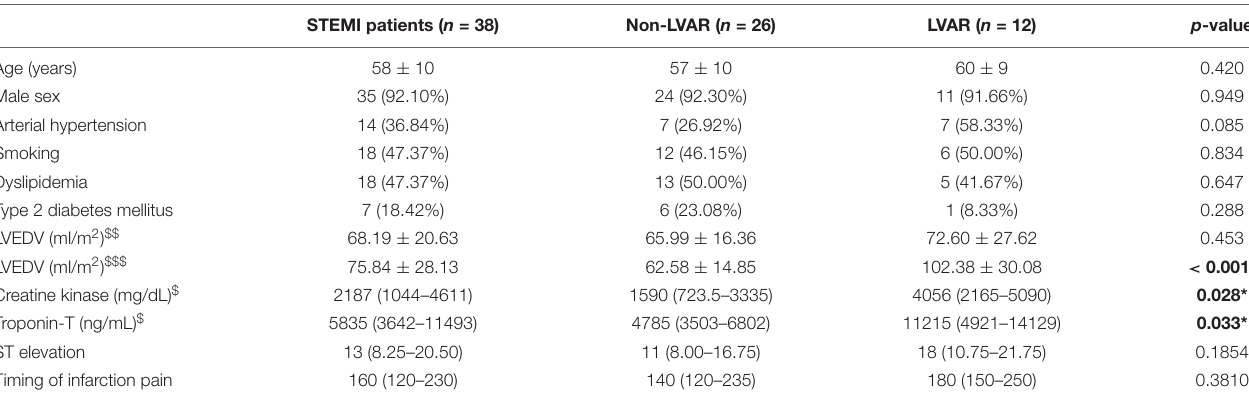
FIGURE 1 | Granulocytes, monocytes and monocyte subsets levels in STEMI patients measured by flow cytometry. (A) Flow cytometry strategy with a dot plot gated in CD11b+ cells is used to identify neutrophils (CD11b+, CD16+, CD66b+, blue) and eosinophils (CD11b+, CD16-, CD66b+, red). (B,C) Bar graphs show levels of neutrophils (B,C) eosinophils in healthy controls (gray dots, n = 28) compared with the levels in STEMI patients (green dots, n = 38) measured in peripheral blood (PB) at 0 h (before revascularization), 6 h (after revascularization), 1 month and 6 months. (D) Representative flow cytometry diagrams of a patient’s PB sample depicting monocyte subsets: non-classical (patrolling, CD11b+ CD14+ CD16++, pink), intermediate (inflammatory, CD11b+ CD14+ CD16+, blue), and classical (phagocytic, CD11b+ CD14+ CD16-, black) monocytes. (E–G) Quantification of the level of classical (E) , intermediate (F) and non-classical (G) monocytes in controls and STEMI patients at 0 h, 6 h, 1 month and 6 months after the ischemic event. Values are presented as the means ± SEM. Kruskal–Wallis test with multiple comparisons corrected by Dunn’s test was performed. (*), (**), (***) and (****) indicate significance at p < 0.05, p < 0.01, p < 0.001 and p < 0.0001, respectively. PB, peripheral blood; STEMI, ST-elevation myocardial infarction. TABLE 1 | Demographic and clinical characteristics of STEMI patients ( n =